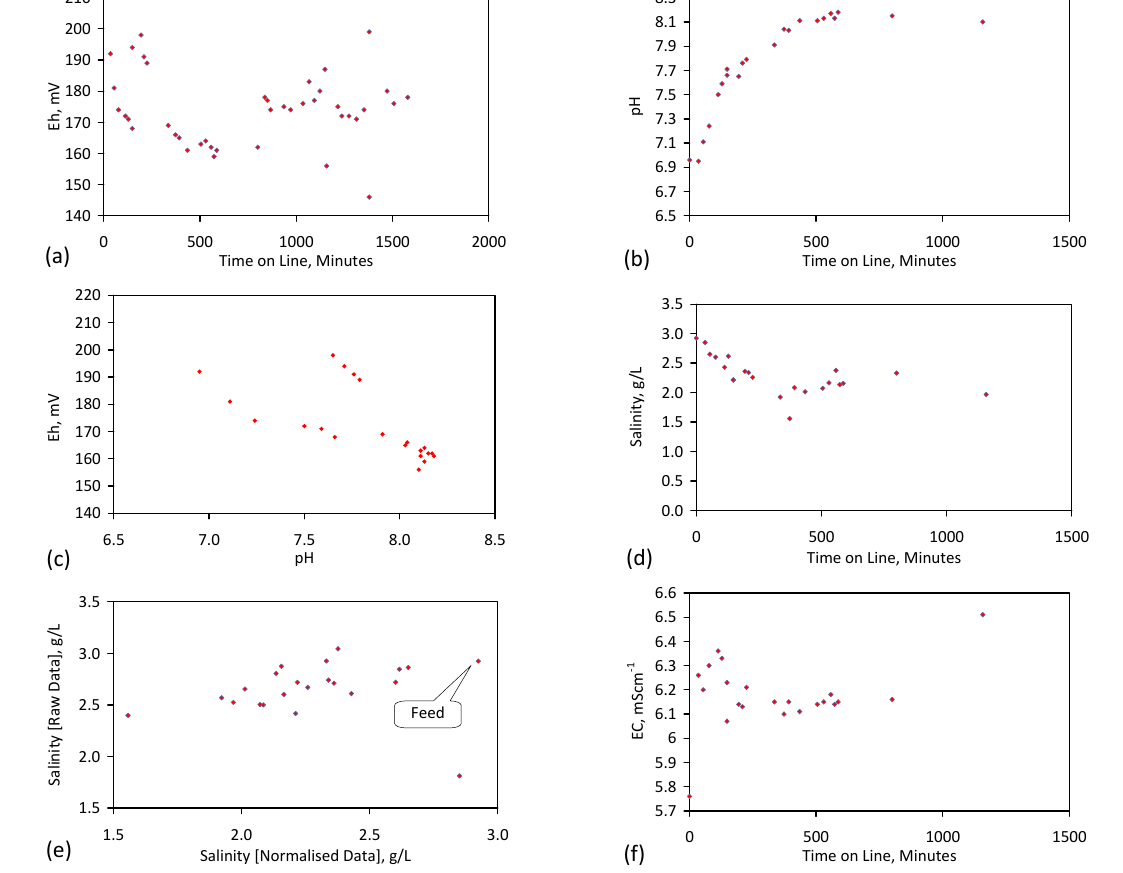
Figure C24. ZVM TPA example Trial E146. 4th Reuse; Operating Temperature: 15–22 °C; Oxidising Environment: Water volume in the reactor = 0.24 m 3 ; ZVM TPA from Trial E145 in a cartridge = 0.4 kg; Air flow = 120 L·h − 1 . ( a ) Eh vs. time; ( b ) pH vs. time; ( c ) pH vs. Eh; ( d ) Salinity vs. time; ( e ) Salinity calculated from normalised data vs. salinity calculated from raw data; ( f ) EC vs.